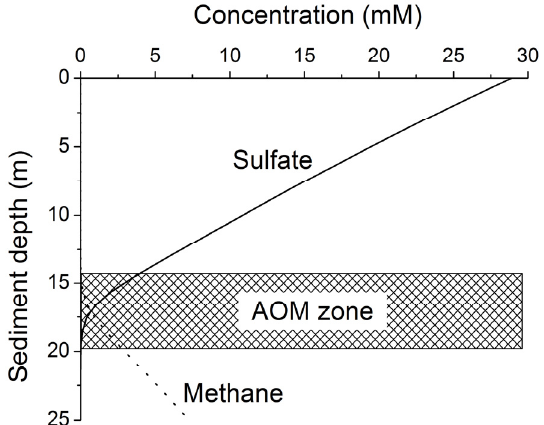
Figure 27. Dissolved sulfate and methane profiles at age Figure 15 for further